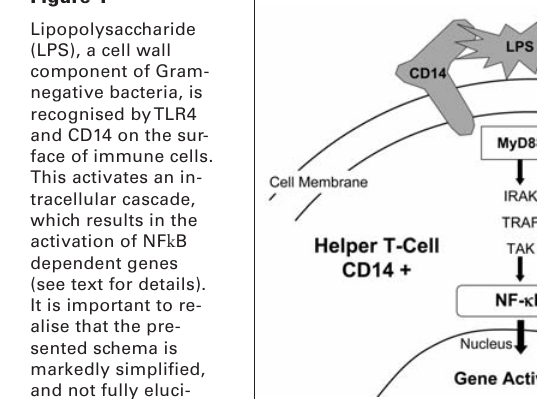
Lipopolysaccharide (LPS), a cell wall component of Gram- negative bacteria, is recognised by TLR4 and CD14 on the sur- face of immune cells. This activates an in- tracellular cascade, which results in the activation of NF k B dependent